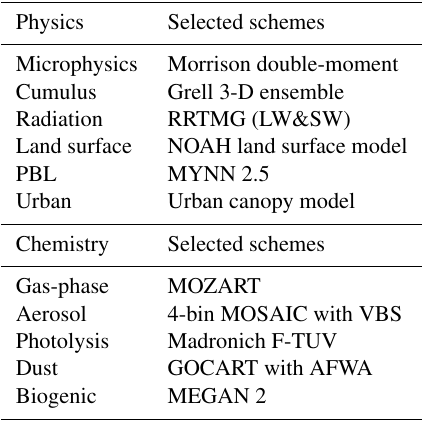
Table 1. WRF-Chem modeling configuration options.